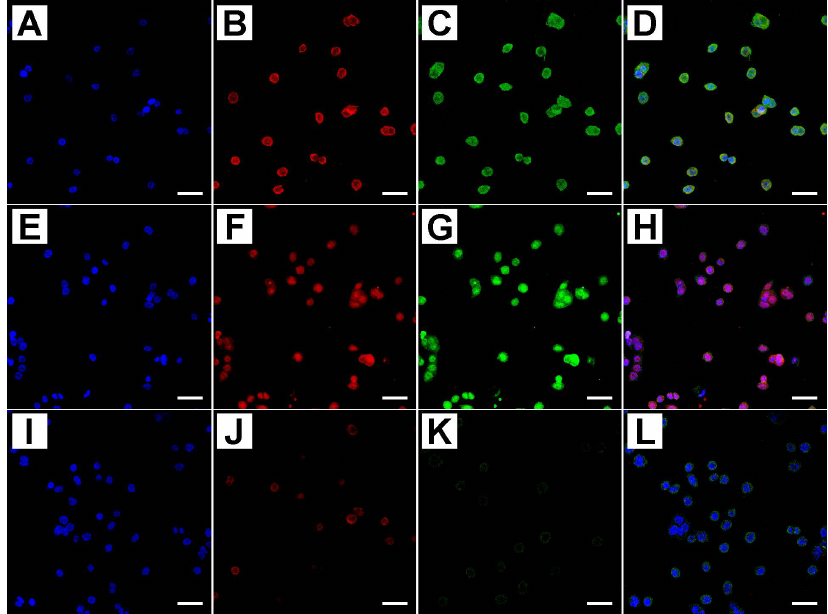
Figure 3. Confocal analysis of PARP-1 and Caspase-3 active proteins in treated and untreated cells with different concentrations of metformin (blue: DAPI; Red: PARP-1 Green: Caspase-3 active; ( D , H , L) : merge). Cells that were treated with 10 mM MET for 24 h showed a strong immunostaining for both proteins ( A – D ), as well as cells treated with 25 mM MET for 24 h ( E – H ). Untreated cells showed a